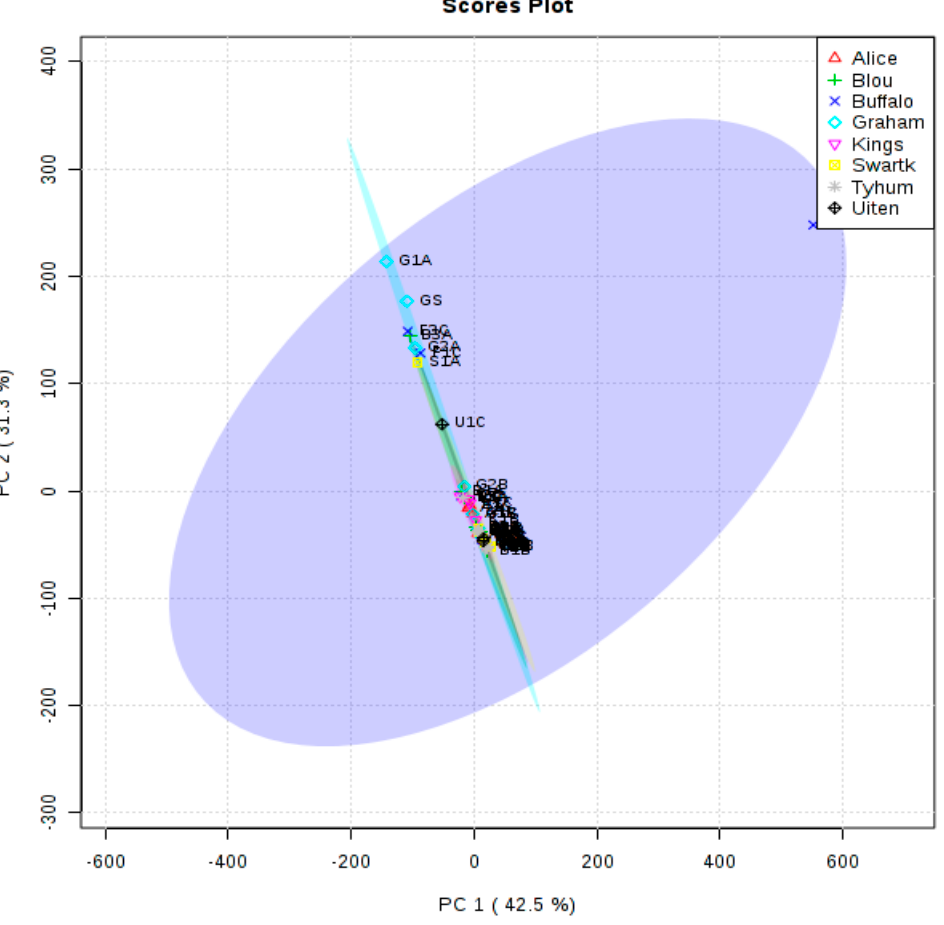
Figure 2. Principal component analysis scores plot between selected principal components (PCs). The variances are in brackets.